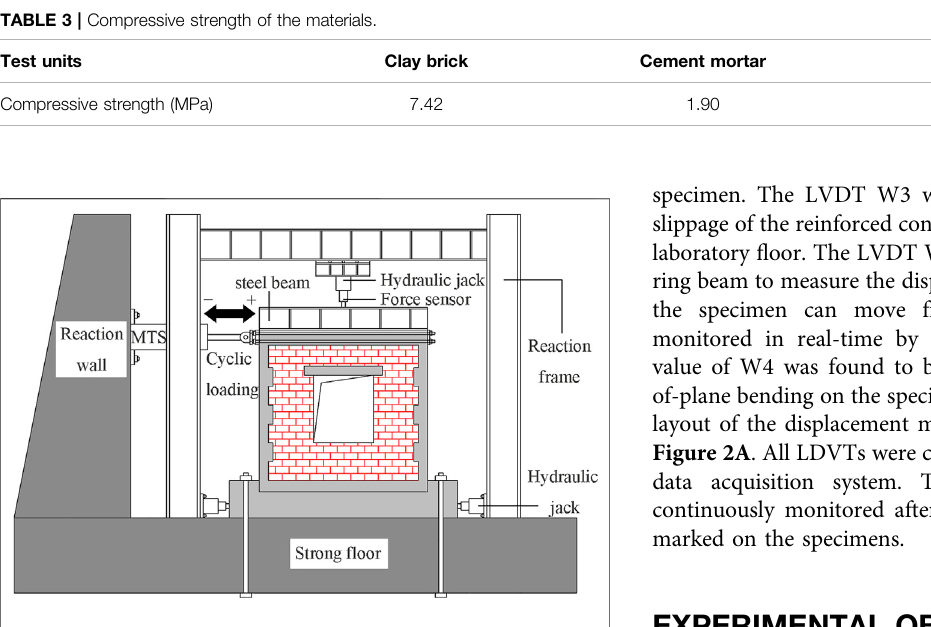
FIGURE 3 | Schematic diagram of the test setup.